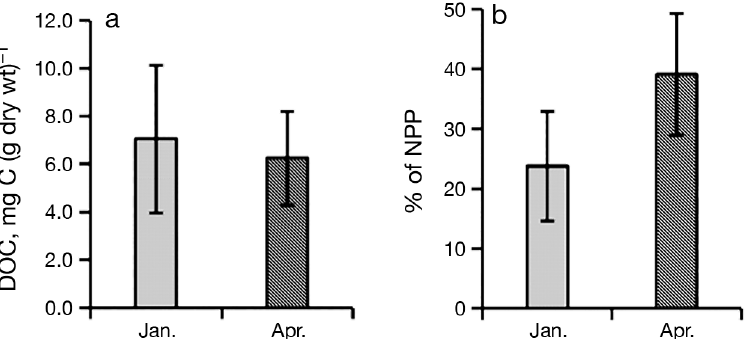
Fig. 4. (a) Dissolved organic carbon (DOC) production rate and (b) DOC per- cent of NPP in January and April incubations. Data are mean ± SD, n = 6